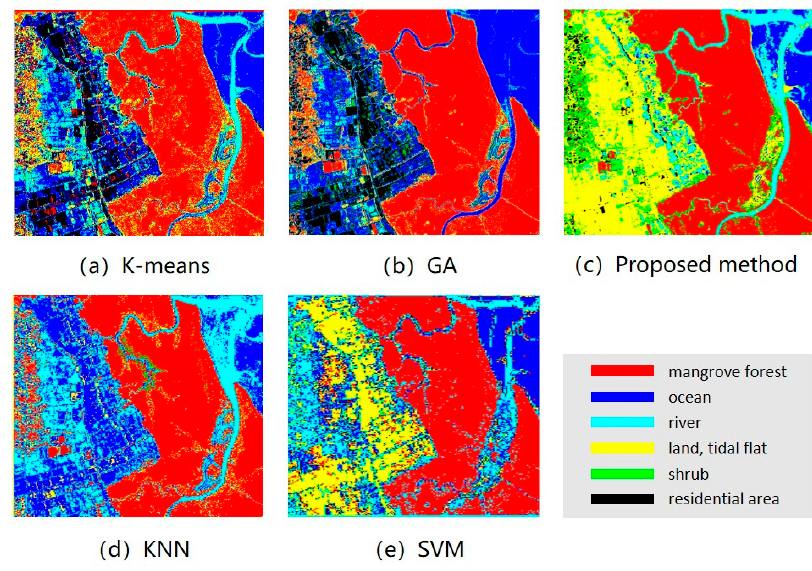
Figure 16. Output results for Data 3. Table 6. Test Results for IoU Parameter (Data 3).